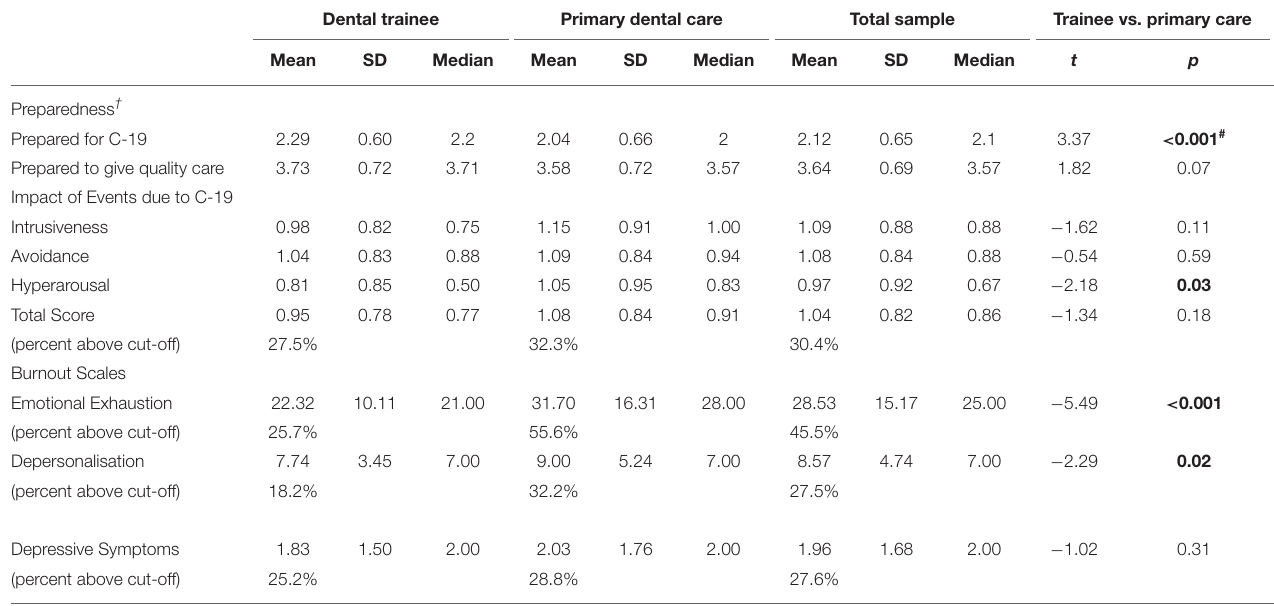
TABLE 2 | Means (SDs) medians, and percent above cut-off of psychological constructs across the two major staff groupings with t statistics and p levels. Dental trainee Primary dental care Total sample Trainee vs. primary care Mean